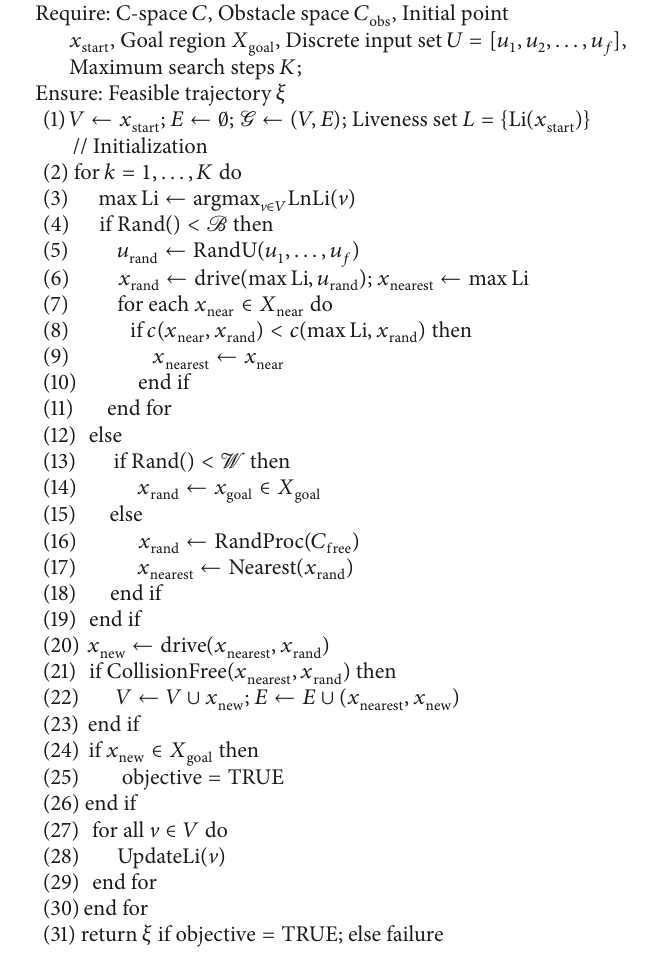
Algorithm 2: Liveliness-based RRT algorithm.